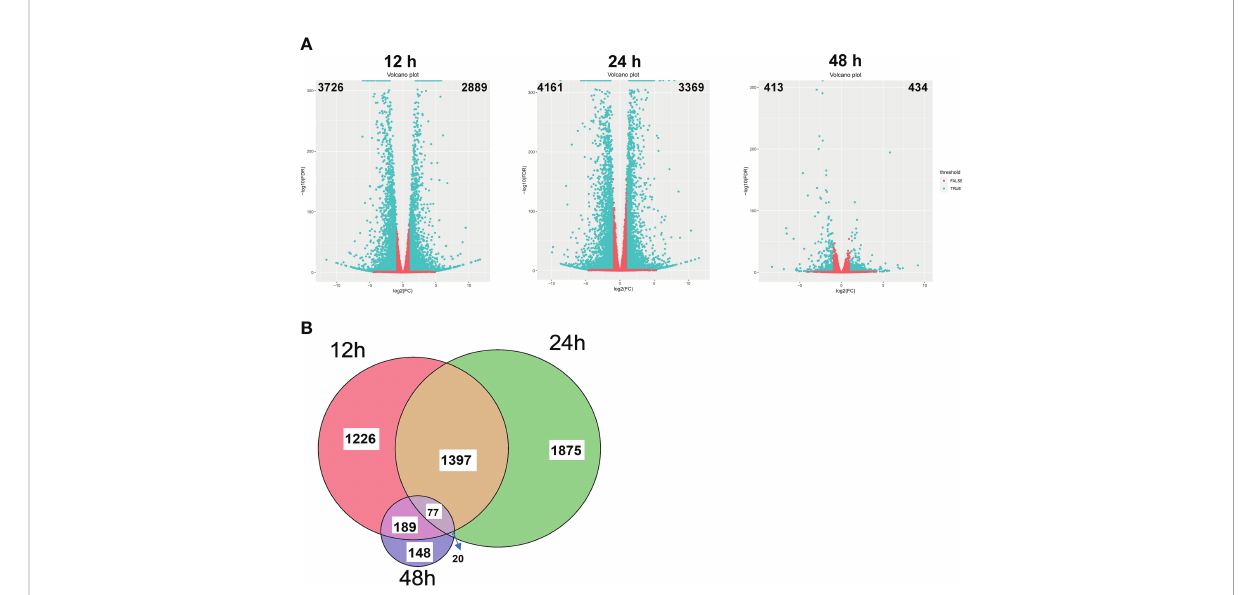
FIGURE 2 Transcriptomic changes induced by NaBT treatment. (A) Volcano plot of differential gene expression at 12, 24 and 48h induced by 10 mM NaBT. Red dots indicate genes with unchanged expression, and blue dots indicate differentially expressed genes (DEGs). Overlapping of up-DEGs (B) at 12, 24 and 48h treated with 10mM NaBT is presented by venn diagram.